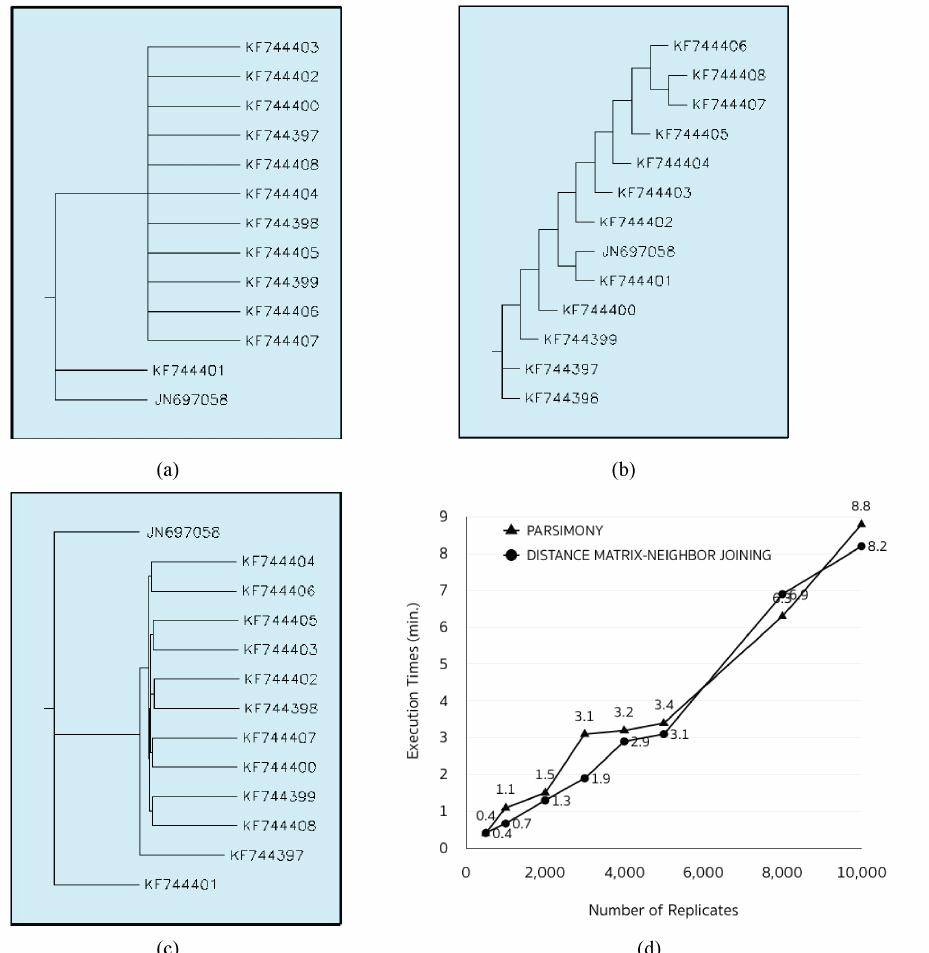
Figure 6: The phylogenetic tree of PARS (a), DIST-NJ (b), ML (c) and the comparison of the PARS and DIST-NJ algorithms in terms of relationship between the execution time and the number of replicates